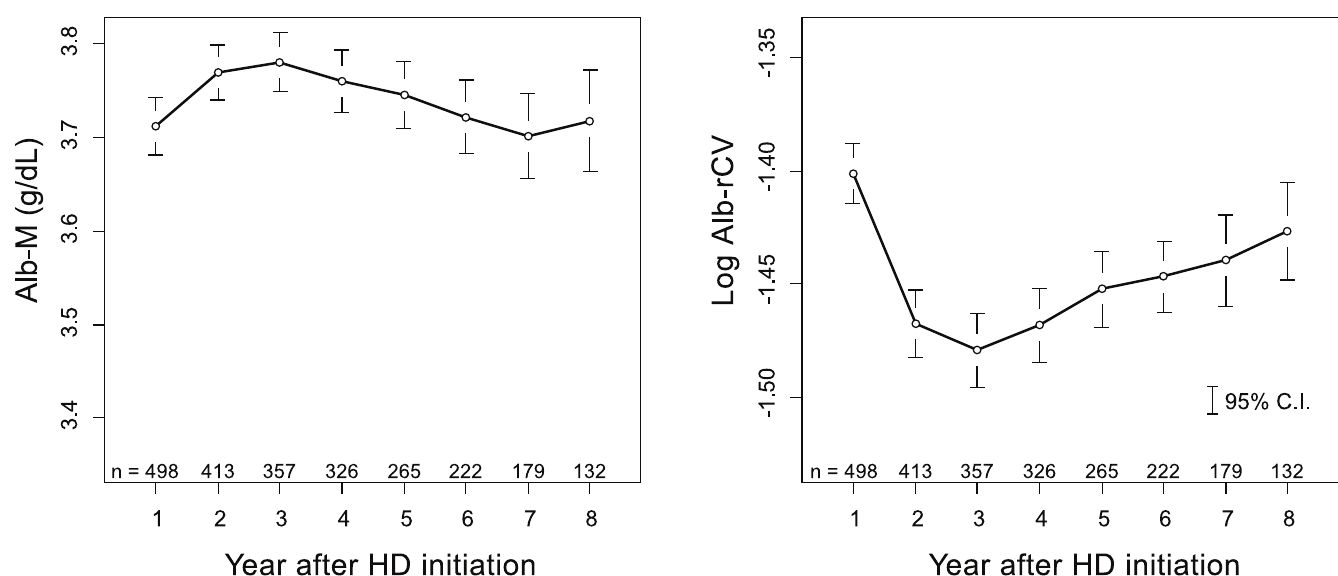
Fig 7. Yearly trends in albumin levels and variability after HD initiation. Individually calculatedAlb-M and log Alb-rCV values were averaged for each year and plotted with their 95% confidenceintervals. The numberof patients includedin each year is shown in the figures. The vertical scales of the graphs are matched with those in Fig 3 to simplify comparisons.